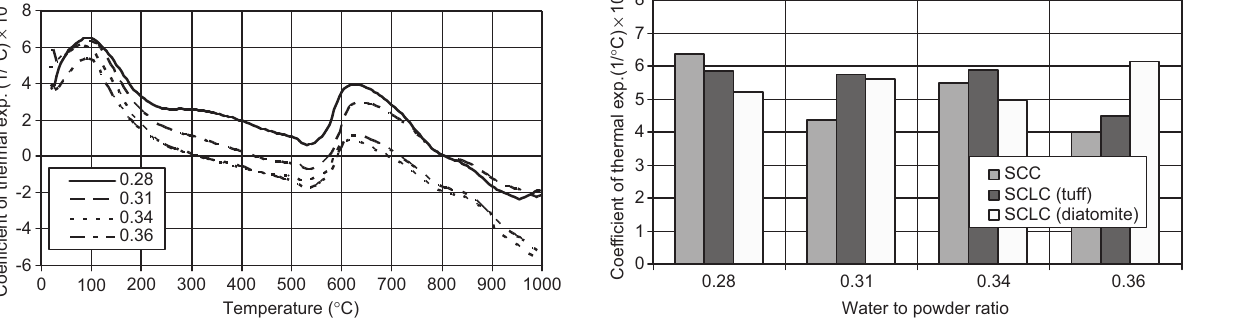
Figure 14 Comparison of CTE values of SCC and SCLC at 55 °